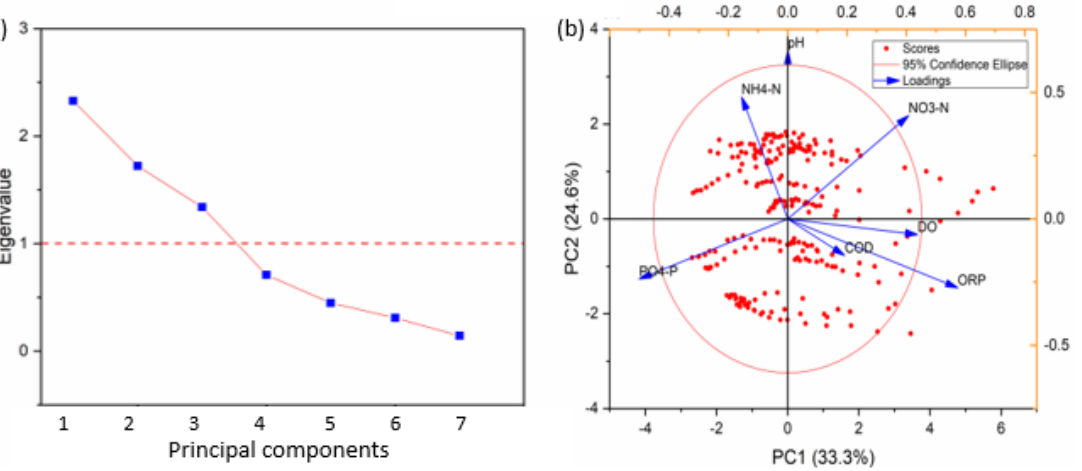
Figure 4. Principal component analysis (PCA). ( a ) Scree plot. ( b ) Biplot on the plane of principle components 1 (PC1) and 2 (PC2); the blue vector represents the loadings of each original variables and the red dots are PCA scores.